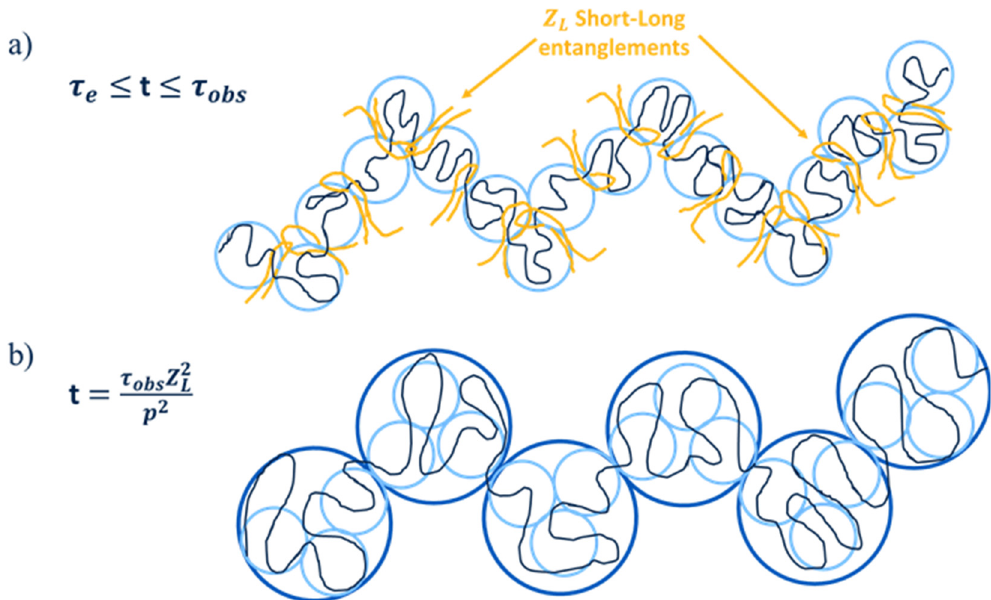
Figure 1. ( a ) Rouse relaxation modes of a self-unentangled long probe chain ( υ L Z L < 2) diluted in a short chain matrix. The relaxation starts from the mode p = N and is followed by slower modes, down to the mode p = Z L corresponding to the entanglement segments (blue blobs). The latter are relaxed at time t = τ e , after which the intrinsic Rouse relaxation is stopped. ( b ) CRR relaxation process taking place for all the modes 1 ≤ p < Z L (the blue blobs represent one of these modes). This process starts at time t = τ obs and ends at time t = τ obs Z 2 , which corresponds to the relaxation of the whole L